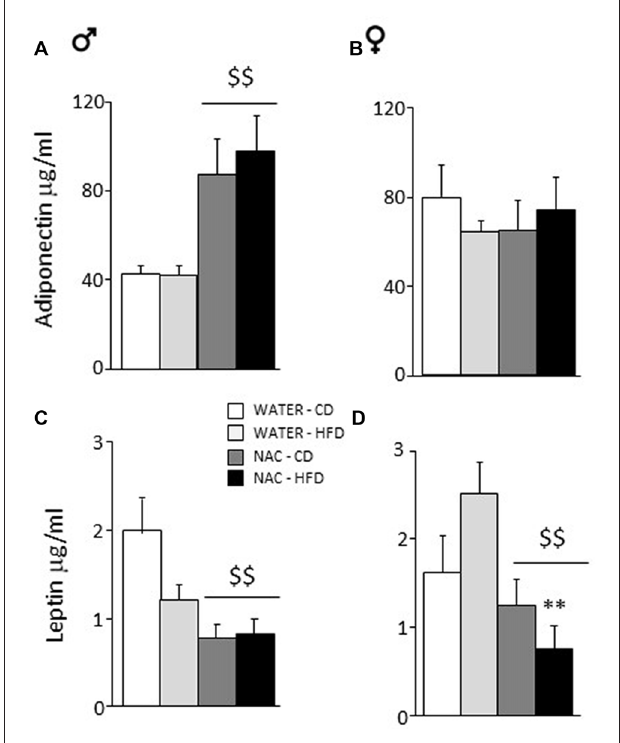
FIGURE 4 | Adiponectin and Leptin plasma levels. (A) NAC increased adiponectin in males while (B) no effect was observed in females. (C) An opposite effect of NAC was observed for leptin levels in males. (D) In females, this reduction of leptin levels was much stronger since they were more vulnerable to the effects of HFD. Data are mean + SEM. Main effect of NAC: $$ p < 0.01 (A,C,D) ; ∗∗ p < 0.01 (D) , NAC-HFD vs. WATER-HFD